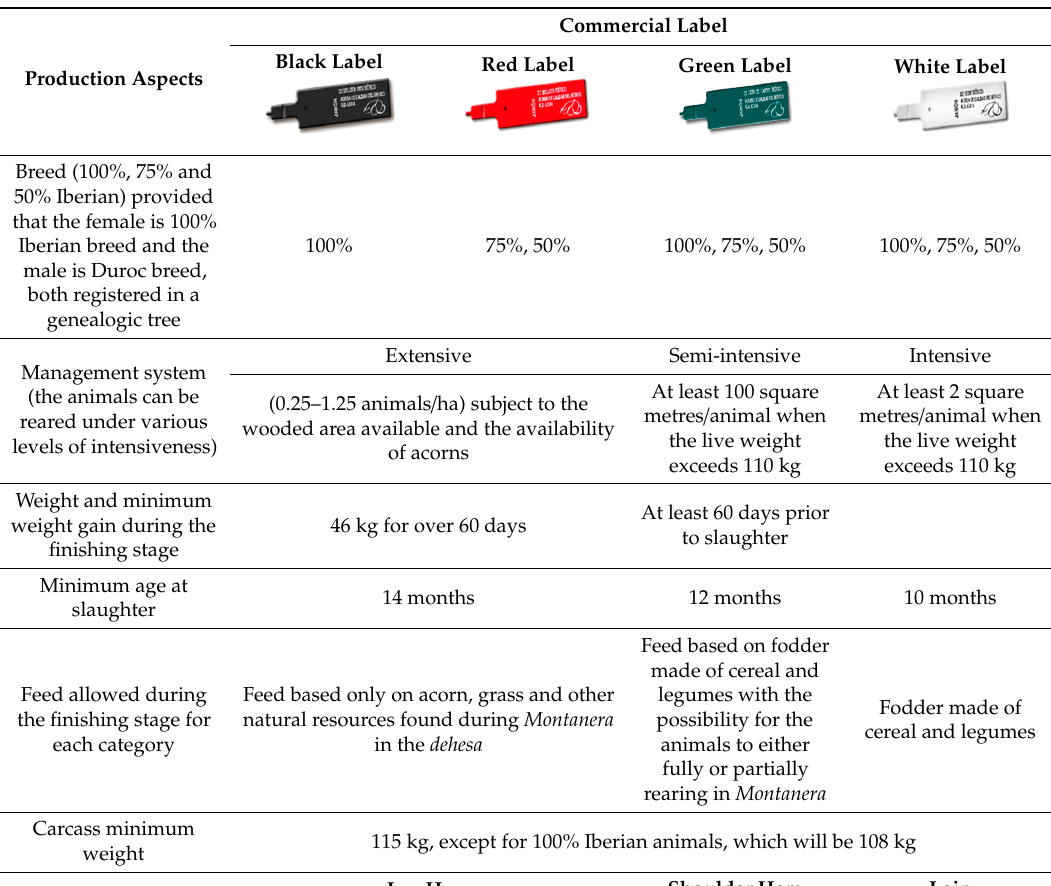
Table 1. Requirements for the production aspects of the various categories of Iberian products and manufacture minimum times according to the current Quality Standard (QS).